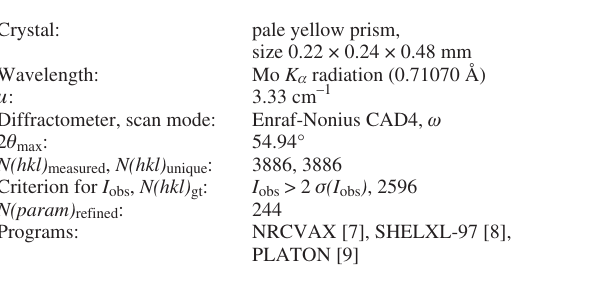
Table 1. Data collection and